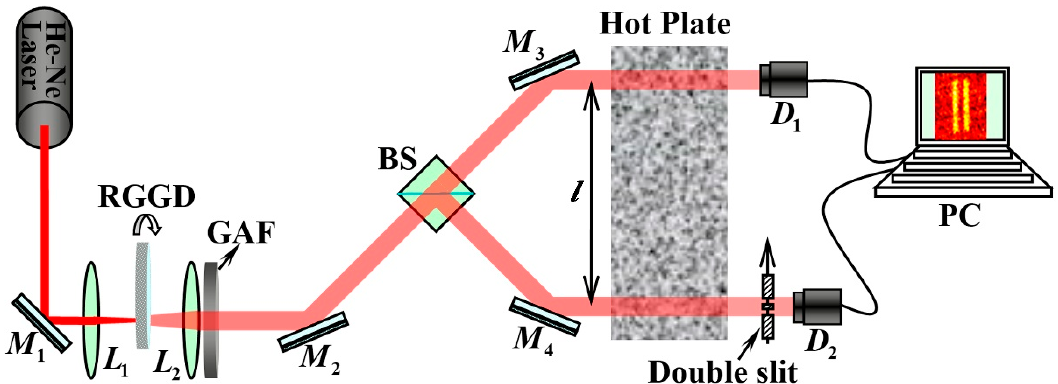
Figure 6. Experimental setup for the lensless ghost imaging (GI) system through thermal-induced turbulence. M 1 -M 4 , mirrors; L 1 , L 2 , thin lenses; RGGD, rotating ground glass dishes; GAF, Gaussian amplitude filter; BS, intensity beam splitter; D 1 , D 2 , detectors; PC, computer.